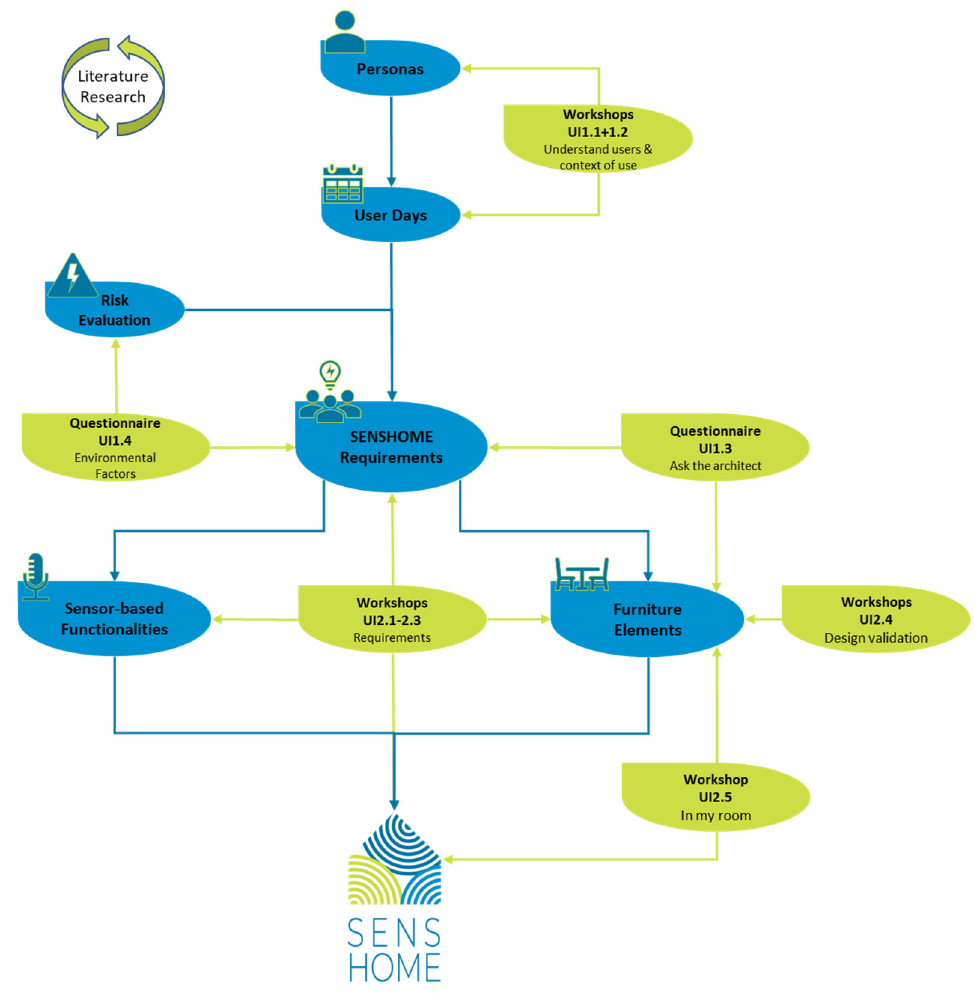
Figure 1. Processes that led to the SENSHOME environment.